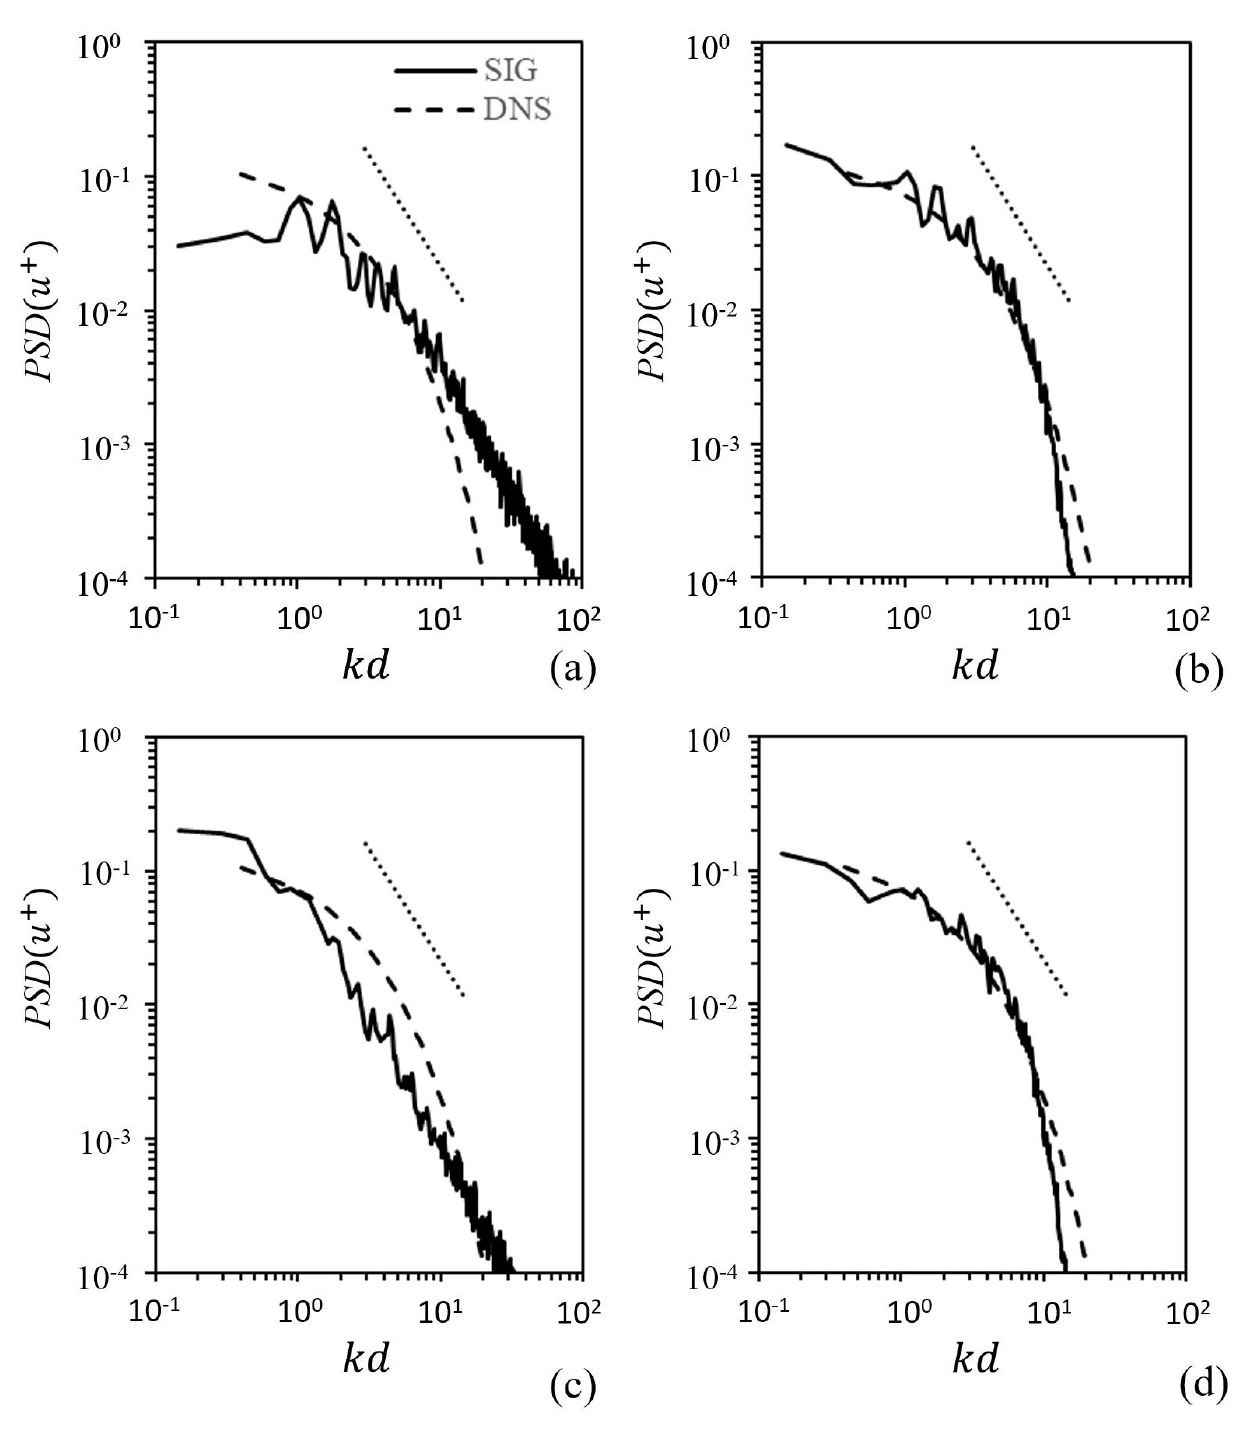
Figure 15. Energy spectrum distribution at the inlet ( a , c ) and for y / d = 50 ( b , d ). In addition, ( a , b ) are the results from Case 01 and ( c , d ) from Case